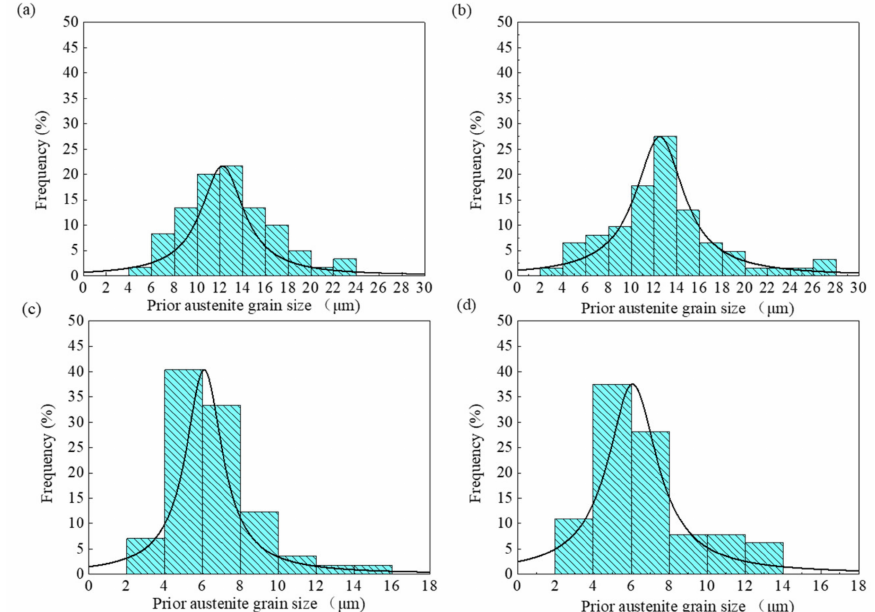
Figure 15. Prior Austenite grain size distribution of steels: ( a ) steel A and ( b ) steel B under conven- tional heating at 880 ◦ C then air cooling (CHA); ( c ) steel A and ( d ) steel B under flash heating to 880 ◦ C then air cooling